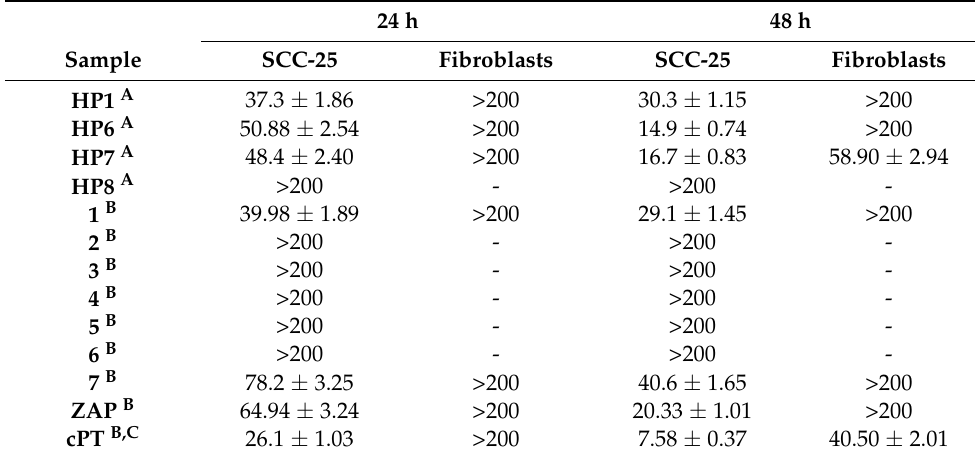
A: expressed as µ g/mL; B: expressed as µ M; all values are represented as the mean ± standard deviation (SD) from at least three independent repeats; C: cPT -cisplatin as a positive control. The morphological profile of SCC-25 squamous carcinoma cells after 24 h and 48 h of